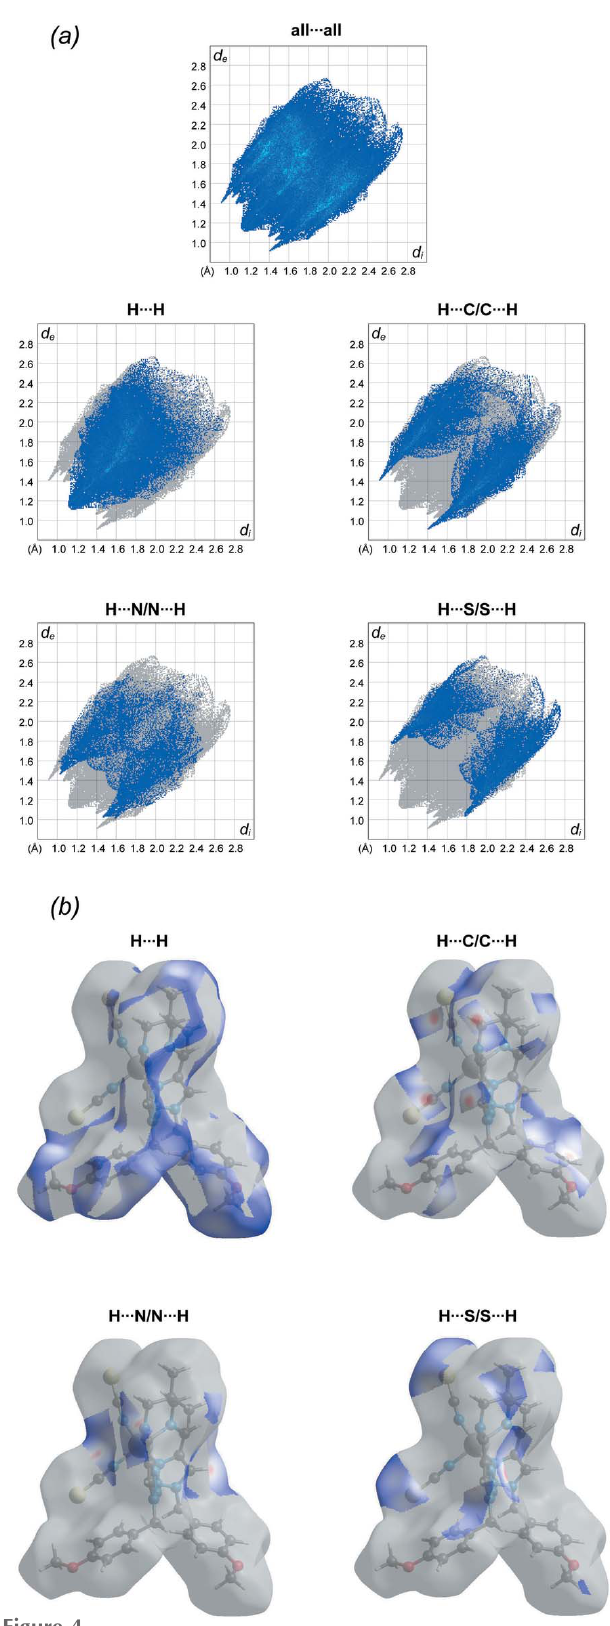
Figure 4 ( a ) The overall two-dimensional fingerprint plot and those delineated into specified interactions. ( b ) Hirshfeld surface representations with the function d norm plotted onto the surface for the different interactions.